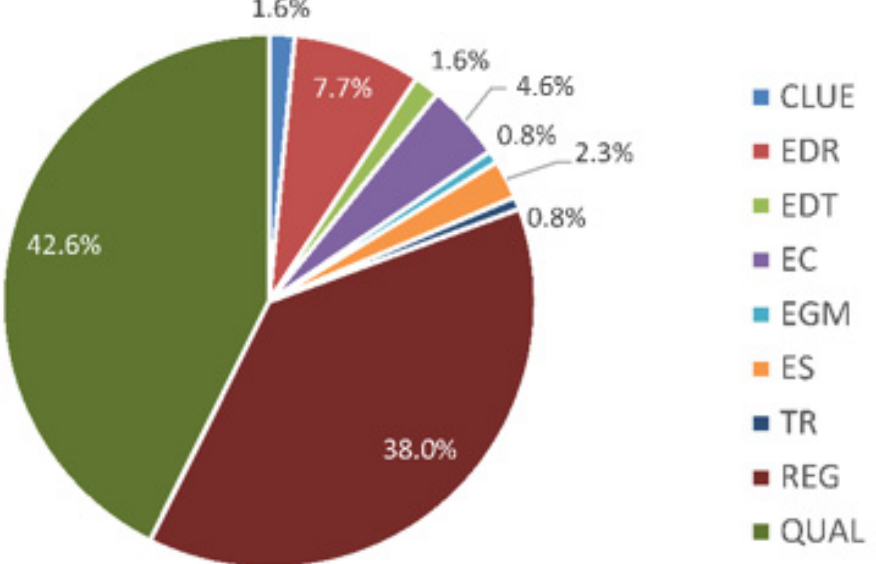
Figure 10. Statistical techniques used for analyzing driving forces of LUCC (129 papers). CLUE: conversion of land use and its effects; EDR: exploratory data reduction; EDT: exploratory data transformation; EC: exploratory classification; EGM: exploratory graphical model; ES: exploratory summarization; TR: training; REG: regression; QUAL: qualitative analysis. Source: own elaboration.